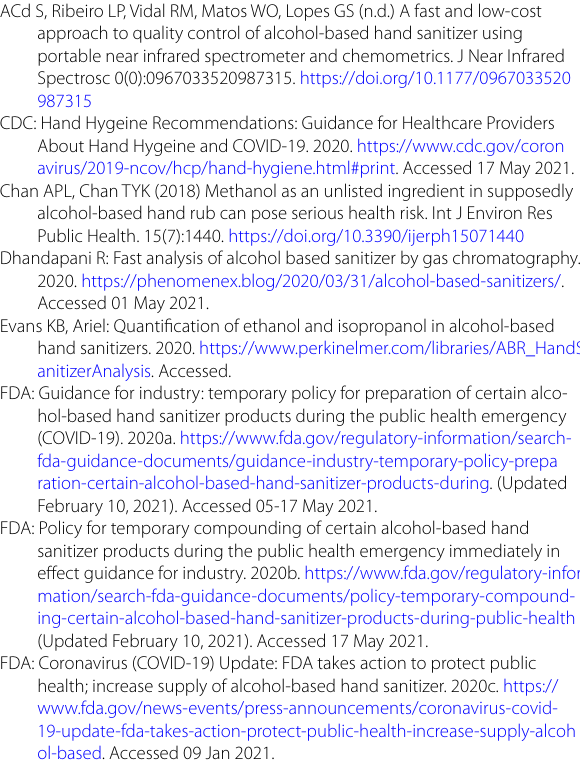
Table 13. Autosampler stability in DMSO, 72 h. Supplementary infor‑ mation Table 14. Autosampler Stability in Hand Sanitizer Products,